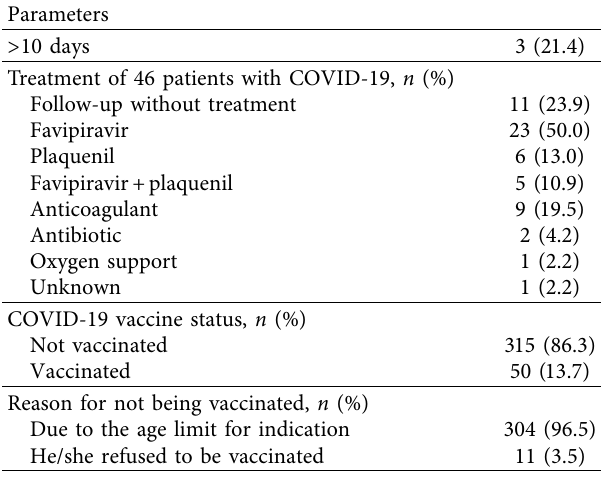
Table 2: Demographic characteristics of the